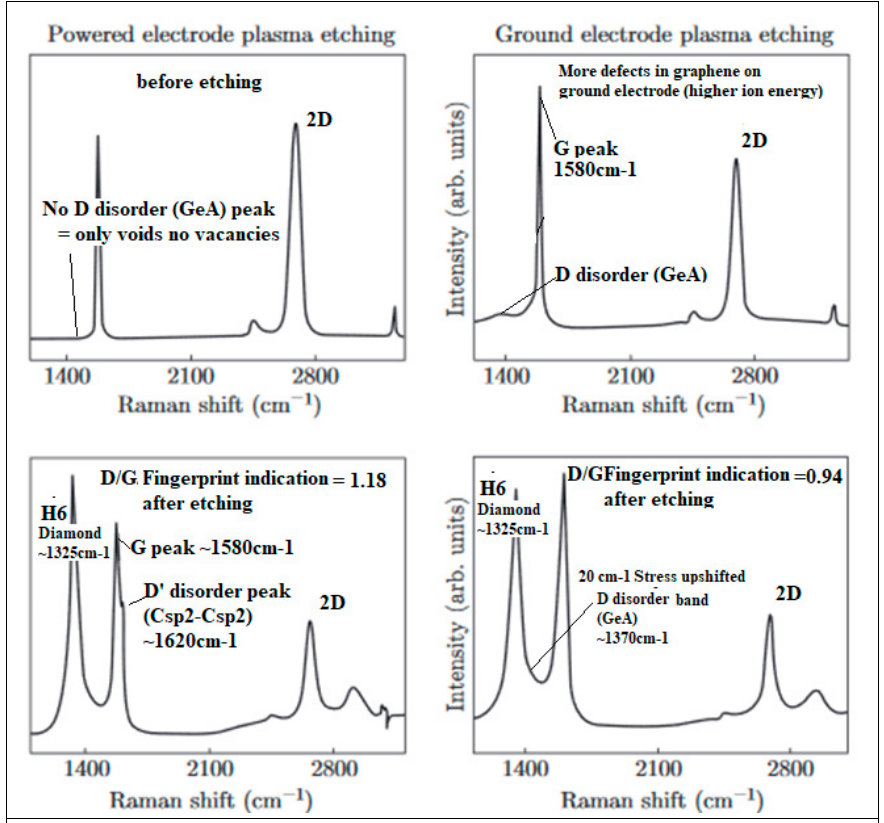
Figure 17. Raman spectroscopic results of oxygen plasma etched graphene by Al-Mumen et al. [205] with permission of Nano-Micro Lett.